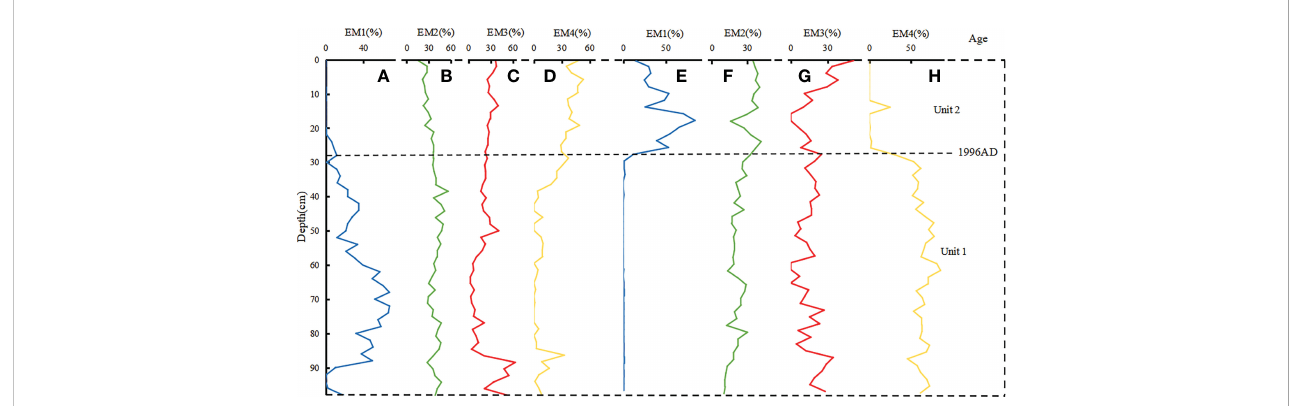
FIGURE 6 Depth distributions of the relative contents of the four EMs of the sediments from cores YDC (A – D) and YDG (E – H)